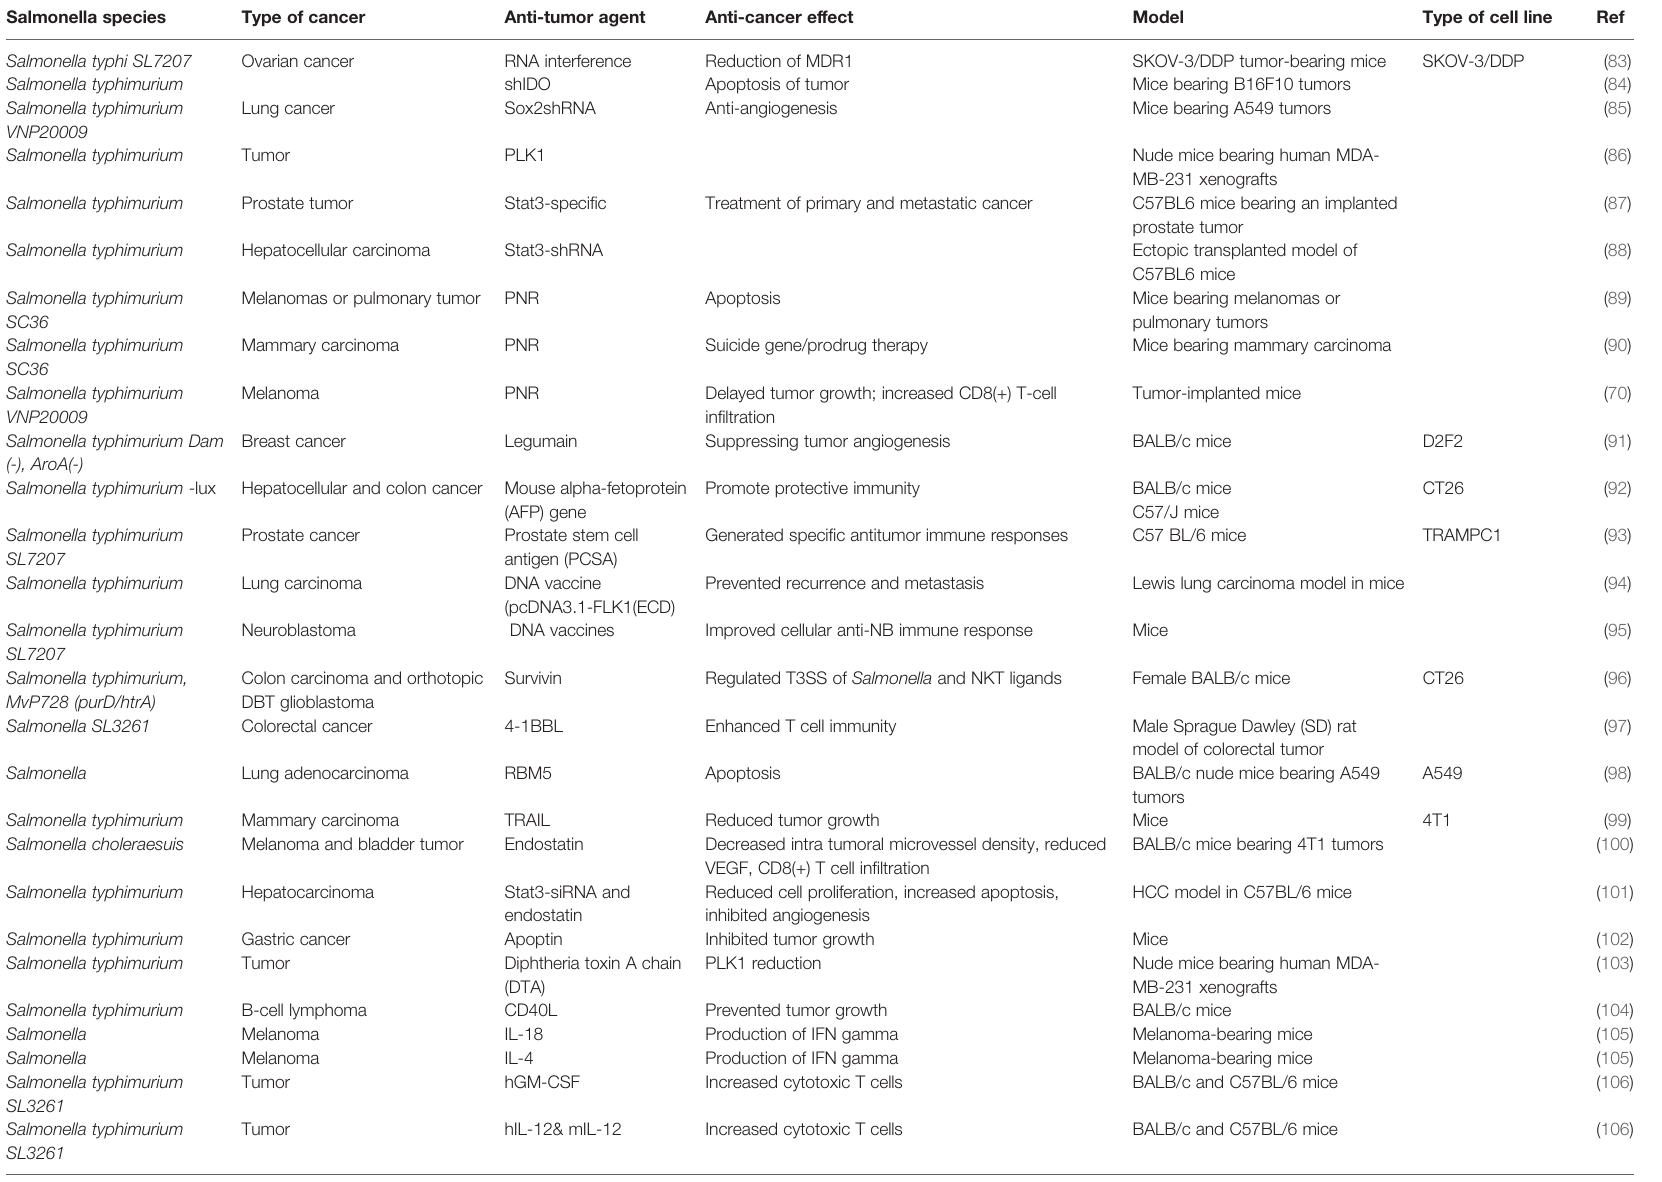
TABLE 1 | Anti-tumor agents that have been delivered or targeted by Salmonella